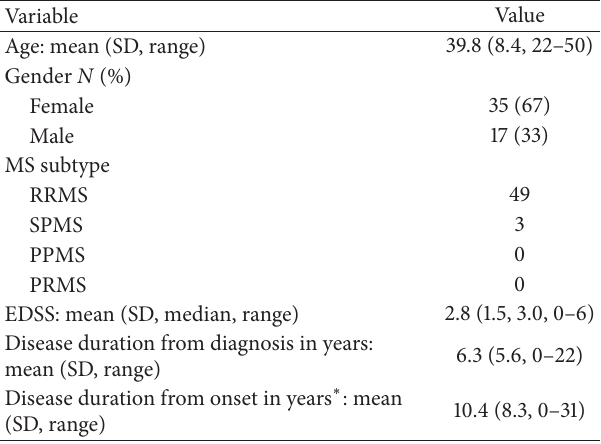
Table 1: Demographics and sample characteristics ( 𝑛 = 52 ).